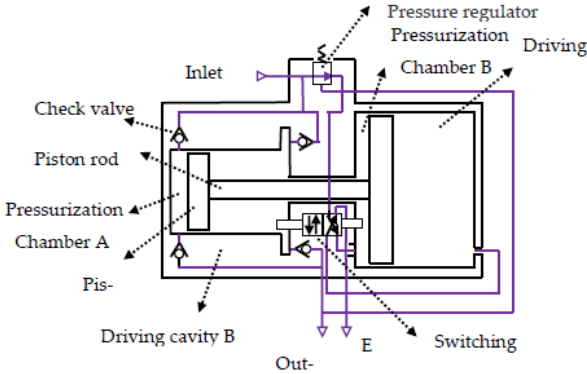
Figure 15. The internal structure of the SMC VBA pressurized valve.